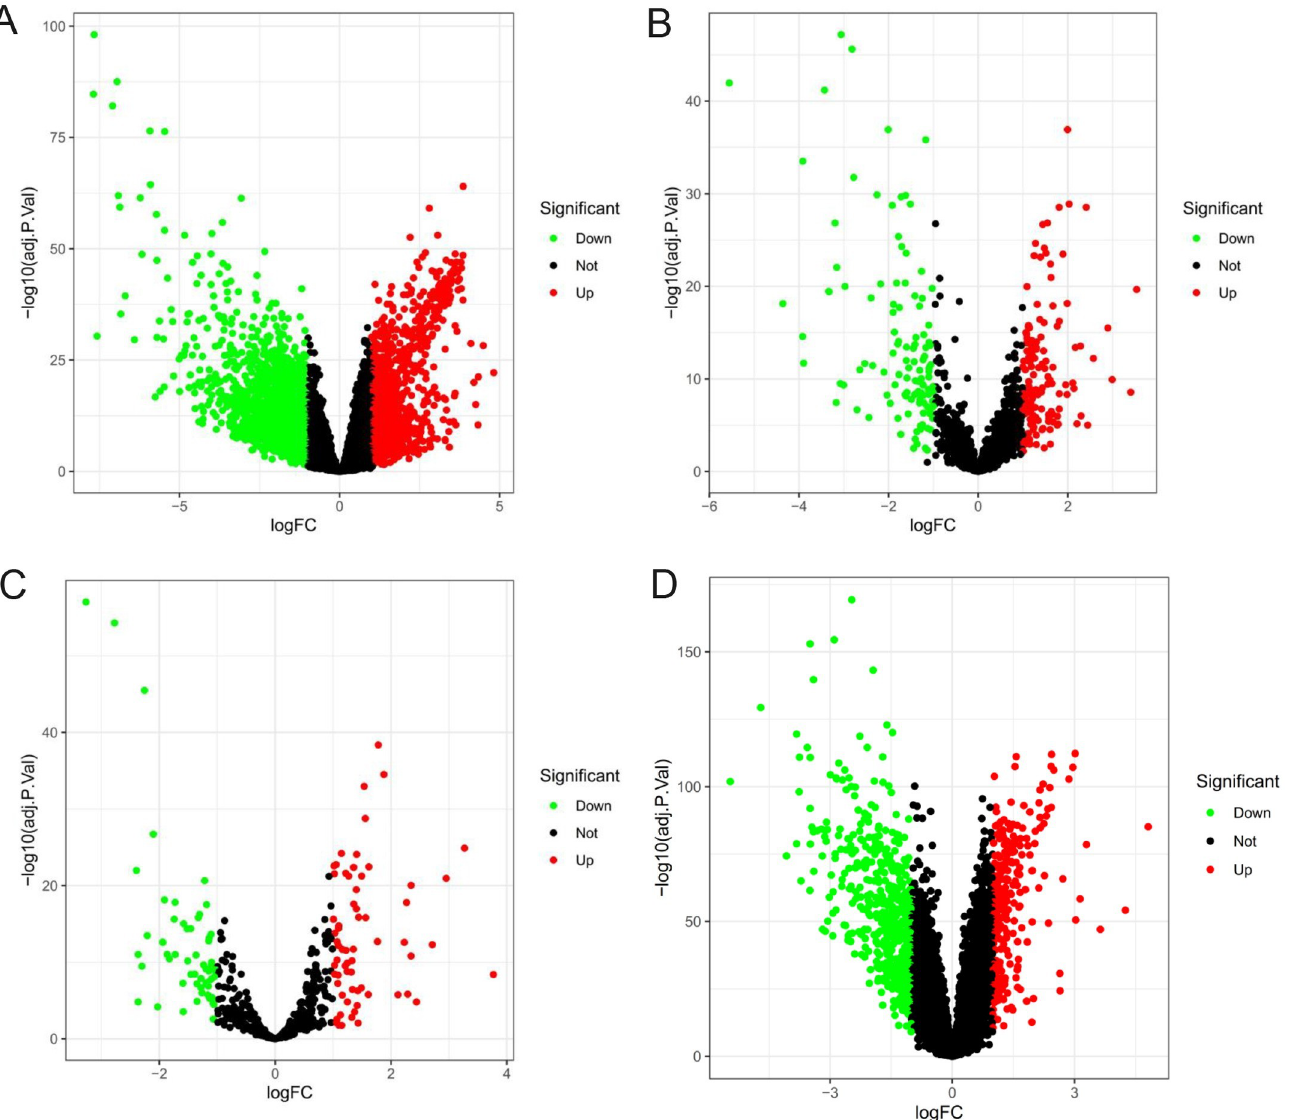
Fig 1. Volcanic diagram of differentially expressed RNAs in patients with HCC. (A) mRNA. (B) lncRNA. (C) miRNA. (D) Differential analysis of GSE14520.